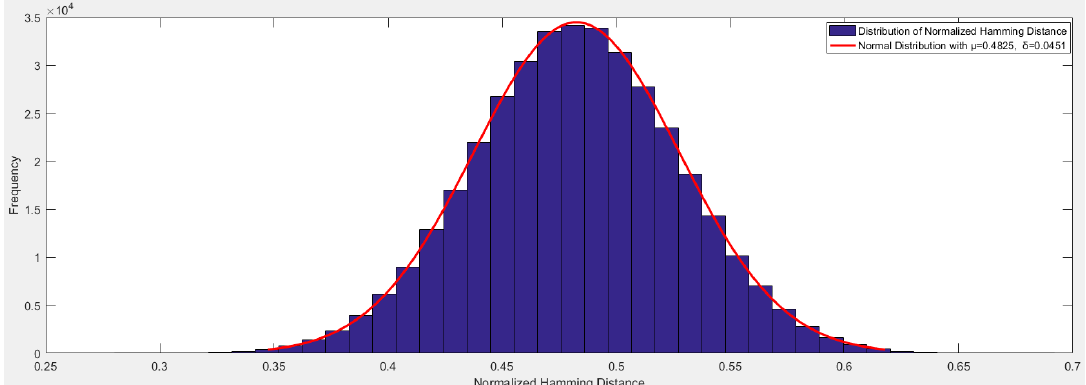
Figure 4. The distribution of 378,400 normalized Hamming distances.